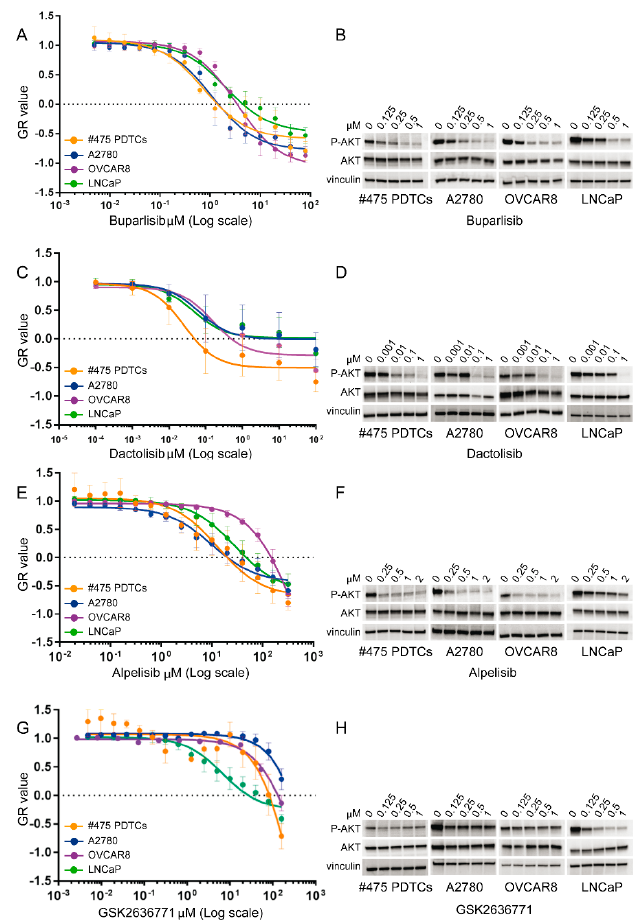
Figure 5. Response of PIK3R1 W624R carrying PDTCs to inhibitors of the PI3K/AKT/mTOR pathway. In each experiment, control cell lines were assayed, too. ( A , C , E , G ): Dose-response curves in CellTiterGlo 72hviabilityassays. Normalizedgrowthrate(GRvalue)inhibitionmetricsofthreereplicateexperiments is shown to take into account cell division rates. The sign of GR values relates directly to response phenotype: positive for partial growth inhibition, zero for complete cytostatic e ff ect and negative for cytotoxicity. The x axis shows drug concentration on a log 10 (Log) scale. ( B , D , F , H ): Western blot analysis of the phosphorylation of the AKT signal transducer in response to drugs, as a proxy of PI3K